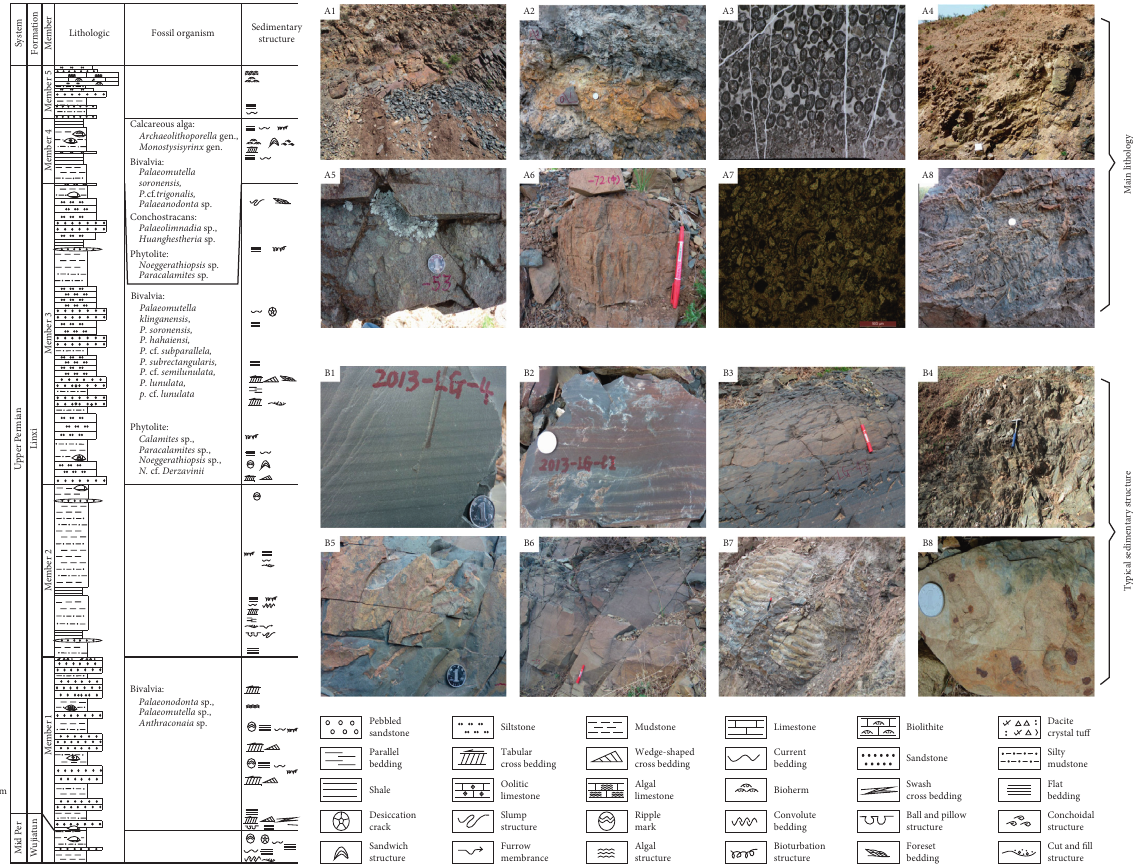
Figure 2: Sedimentary characteristics of the Late Permian Linxi Formation in the Linxi area of eastern Inner Mongolia. A1, gray mudstone, section Lin1. A2, gray silty mudstone interbedded with thin yellowish brown silty mudstone, section Lin1. A3, oolitic limestone, light crystal matrix, containing a small amount of oolitic spherulites. A4, slump conglomerate, indicating gravity flow, section Lin2. A5, gray gravel coarse grained sandstone, gravel size 0.2–1.0cm, subround and subangular gravel that is mainly limestone, section Lin3. A6, laminated limestone with laminated columnar structures, section Lin4. A7, inner clastic granular limestone, particles are mainly inner debris, algae grains, and ooids, section Lin4. A8, framestone with an algae bonding structure, section Lin 5. B1, gray-green silty mudstone with horizontal bedding, section Lin1. B2, gray siltstone with current bedding, section Lin1. B3, lower dark gray mudstone with wash-out structures, unconformably in contact with upper gray sandstone, section Lin 2. B4, gray sandy mudstone with slump and deformation structures, section Lin3. B5, dark gray fine grained sandstone with bioturbation structures, section Lin3. B6, gray fine grained sandstone with tabular cross bedding, section Lin3. B7, gray argillaceous sandstone with ripple bedding and mud cracks, section Lin3. B8, light brown coarse grained gravel sandstone with concretionary structures, section